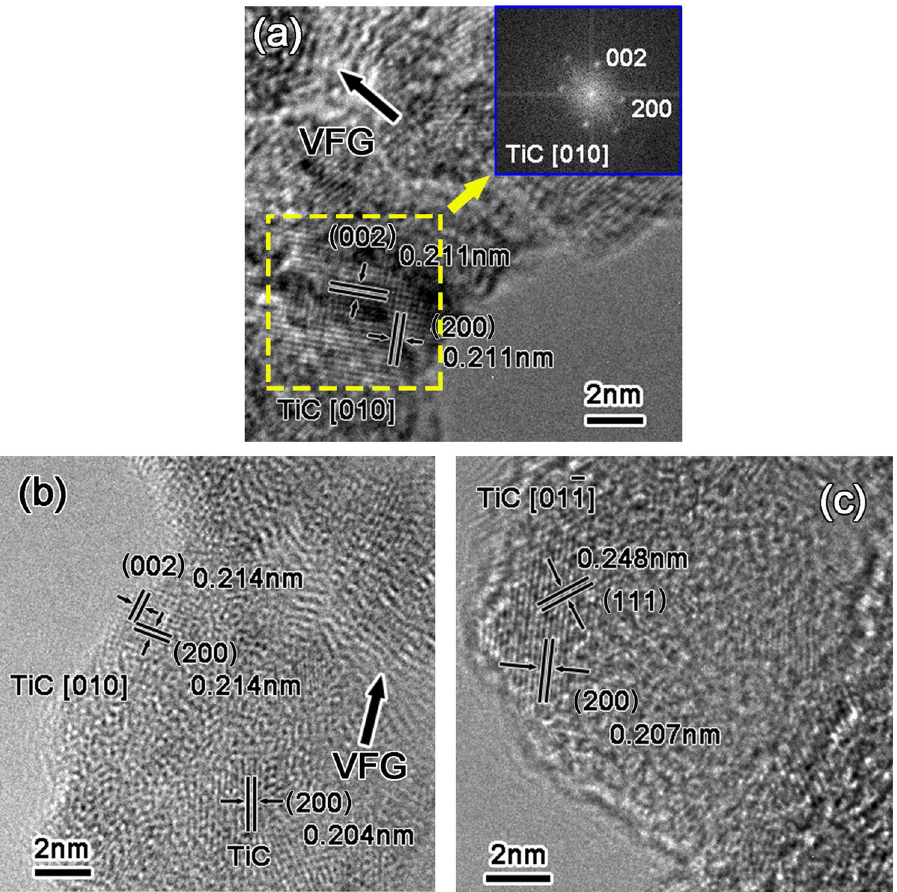
Figure 7. HRTEM images of the VFG after the deposition of Ti: ( a ) without subsequent heat treatment; ( b , c ) annealed at 600 °C for 1